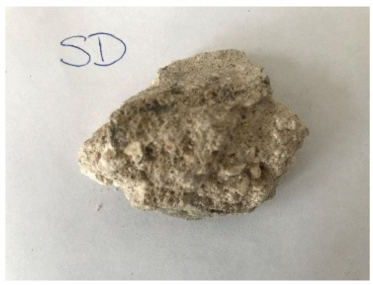
Figure 16. Sample D—sample image.